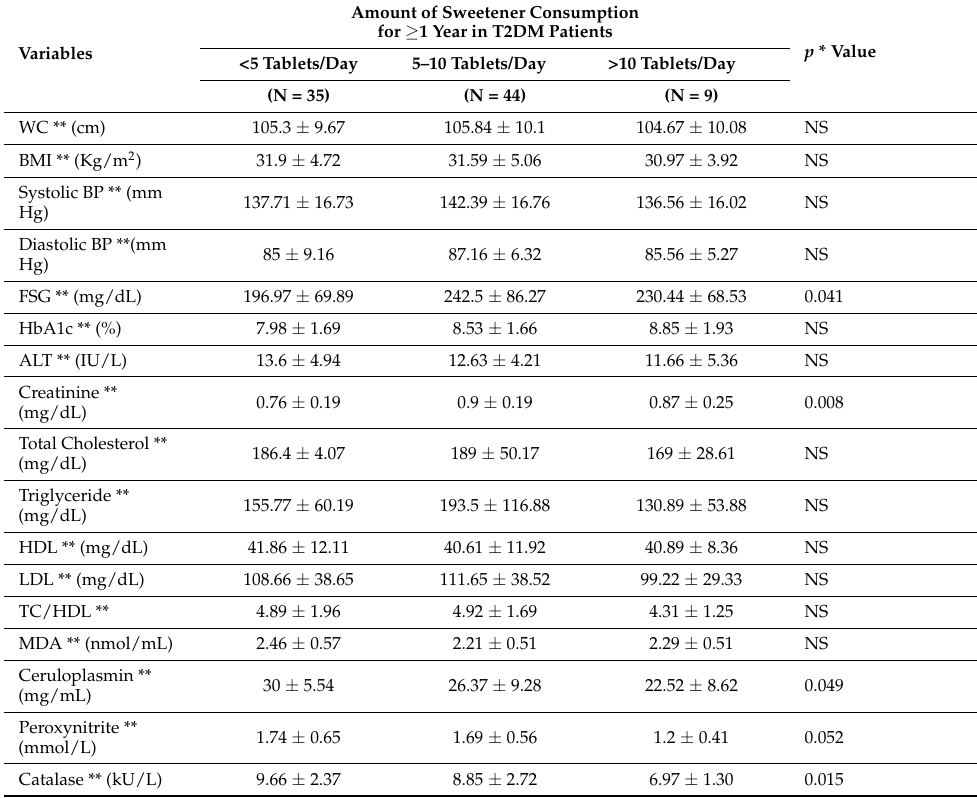
Table 4. Impact of the amount of sweetener consumed for long term among type 2 diabetic patients.